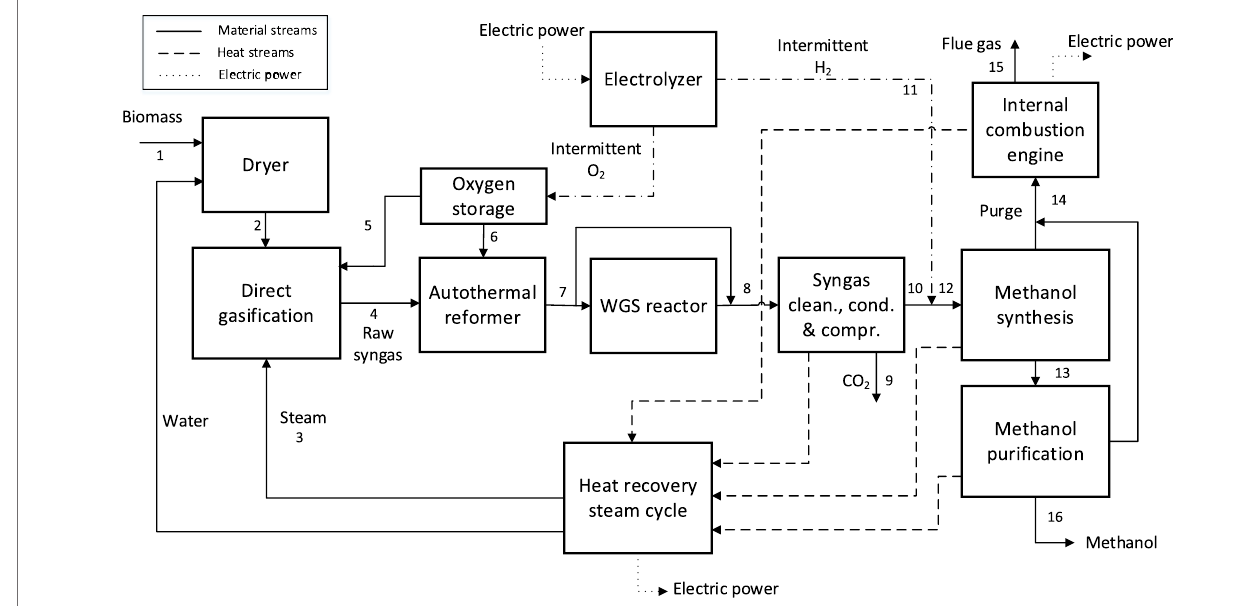
FIGURE 1 | Block diagram of the DG-based power and biomass-to-methanol plant.